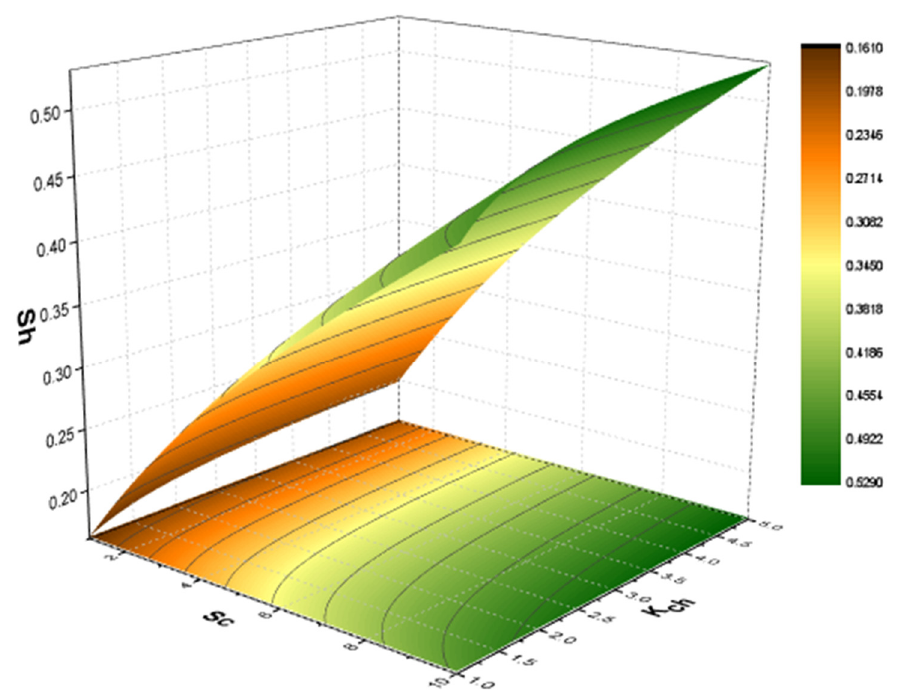
Figure 21. Impact of Sc and K ch on SN.